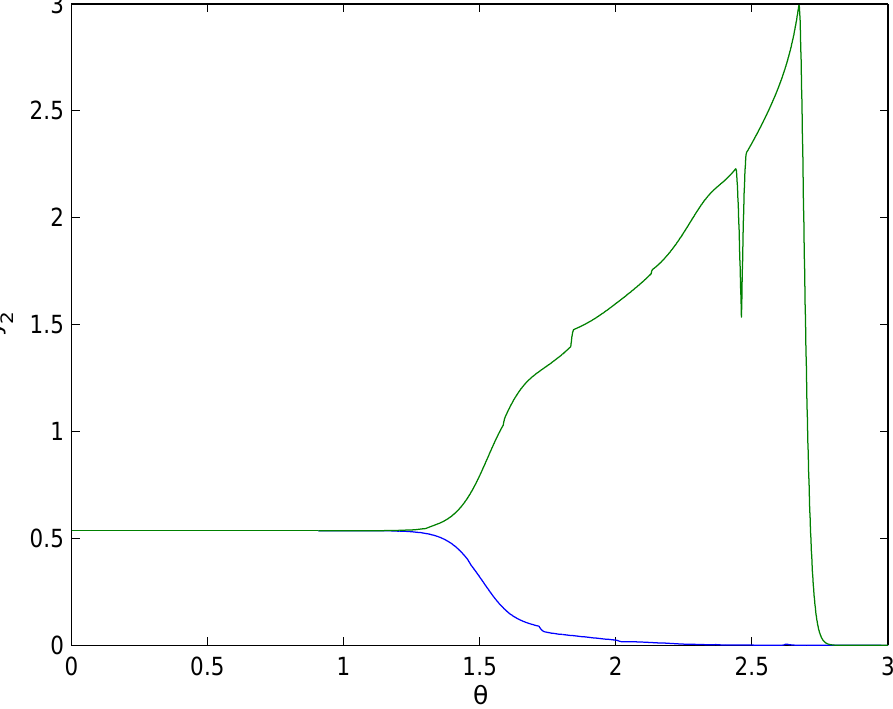
. The bifurcation value is approximately 1